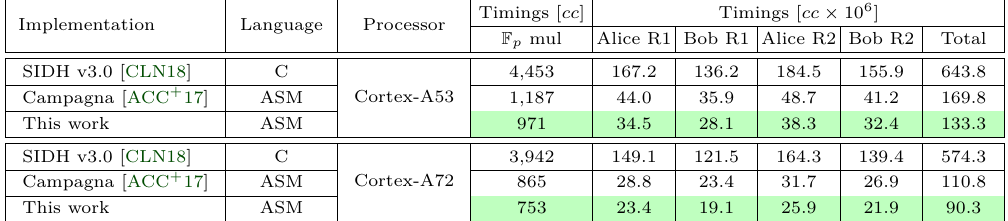
Table 6: Comparison of implementations of the SIDHp503 protocol on ARMv8-A based processors. Timings are reported in terms of clock cycles.